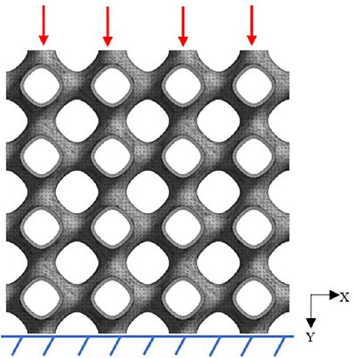
Figure 2. Finite element analysis model of porous scaffold.